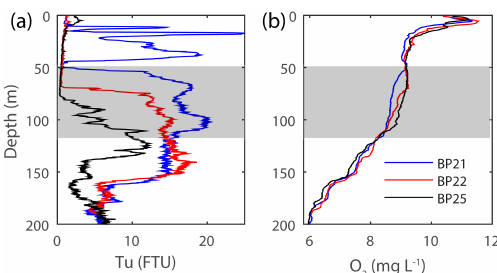
Figure 4. Comparison of turbidity (a) and O 2 (b) depth profiles for the three stations close to the Dranse River mouth. The shaded area corresponds to the upper hypolimnion, i.e. water layers that have been mixed during the preceding winter.